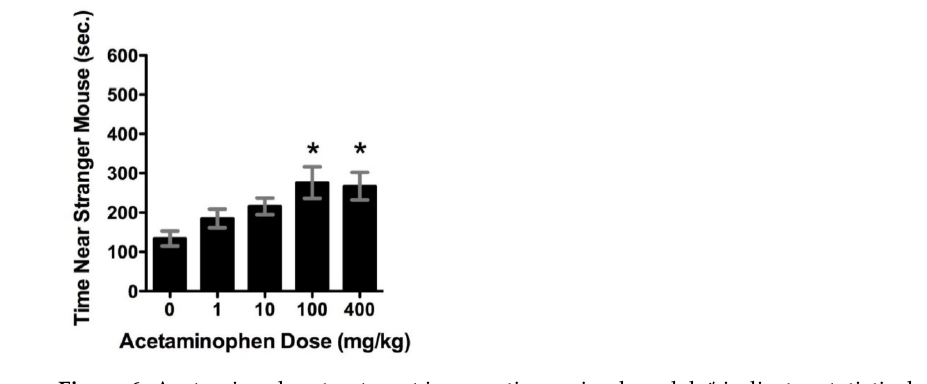
Figure 6. Acetaminophen treatment in an autism animal model. * indicates statistical significance ( p < 0.05) versus non- treated animals. Reprinted from [24], with permission from Elsevier (Amster- dam, The Netherlands) (license #5034221282113).